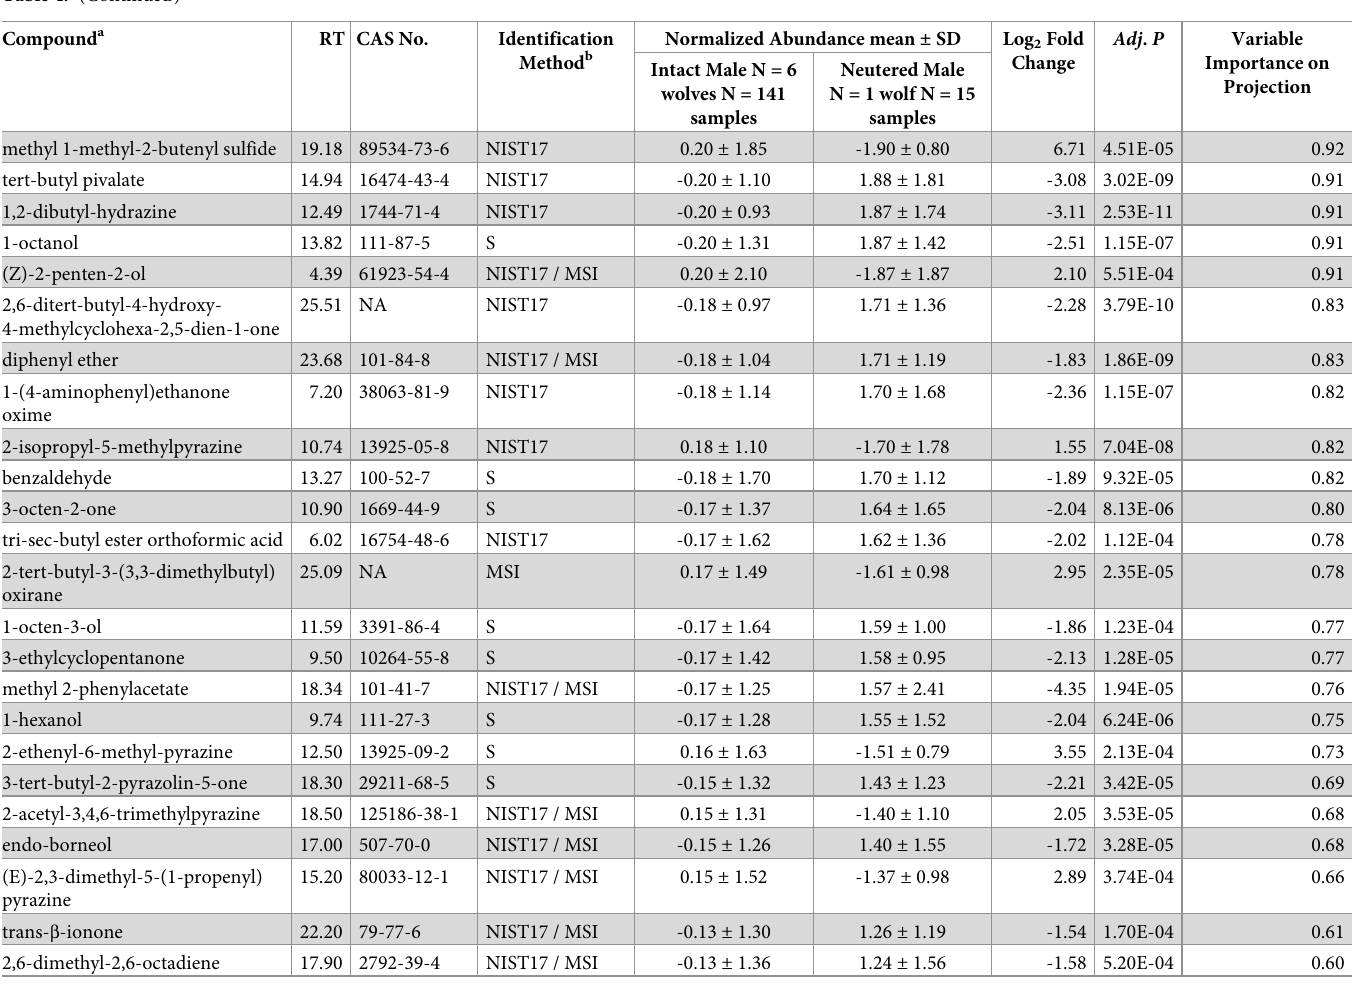
pyrazine, 2-methyl-6-(1-propenyl) pyrazine, tetrahydro-2-isopentyl-5-propyl furan, prenol, and prenyl bromide (Fig 2B). Of the top ten compounds with the highest contribution to the classification, nine were significantly more abundant in the urine of intact males. Differences between paired and unpaired individuals VOCs from males paired with a breeding mate (SB#2660 and SB#2844) (n = 44 samples) were compared to those from males housed without a breeding mate (SB#3206, SB#3192, SB#3195, SB#2810) (n = 97 samples). Following peak picking and grouping procedures, 73 peaks each representing a VOC were analyzed for differential expression. Out of those 73 peaks, four uri- nary VOCs differed ( Adj . P < 0.001 and |log fold change| > 2.0) between paired and 2